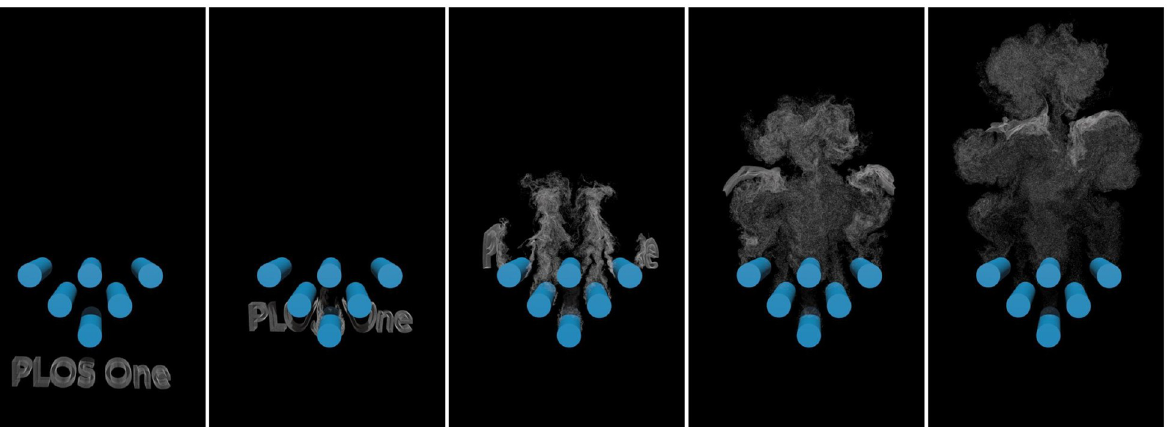
Fig 13 demonstrates the realistic wakes behind the static cylinders. We construct the thin smoke to form the words ‘PLOS One’ and let it pass through the cylinders. The radius of the cylinder is 0.8 unit lengths. In this example, the boundary sampling point is computed in advance like the 2D Karman vortex street example. The vortex particles entering the cylinder are destroyed. The simulation results show that our method can produce dispersive thin smoke. Vortex shedding behind moving objects. The first column in Fig 14 depicts the turbulent wake formed by the moving ball passing through the static smoke. Unlike in the 2D Karman vortex street’s sampling manner, we place massive vortex particles regularly in the static smoke and treat the collision points between the vortex particles and the moving ball as the boundary sampling points. The vortex particles entering the obstacle are destroyed. This means that the number of vortex particles is constant in the simulation. The ball’s radius is 0.5 unit lengths, and the ball moves at a speed of 2 unit-lengths/s.